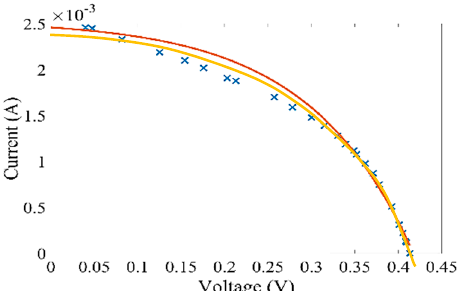
Figure 15. Experimental data acquired ( x ), characteristic curve that approaches the experimental data ( --- ), and simulated characteristic curve ( --- ), for the 650 nm filter.